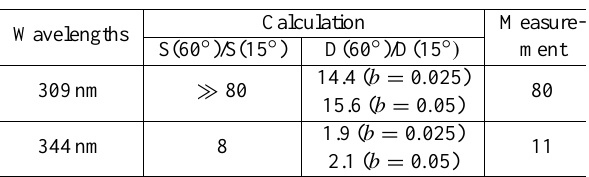
Table 2. A comparison of the measured and model calculated ratios of radiation at two